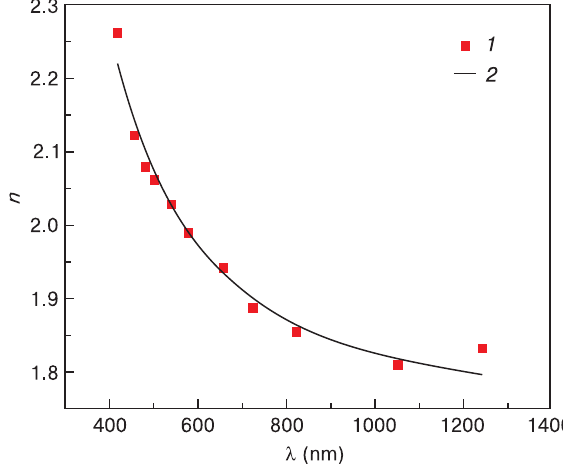
Figure 5. Dispersion dependence of refractive index of typical specimen: ( 1 ) data obtained by calculation using Eq. (16) and ( 2 ) Cauchy approximation.